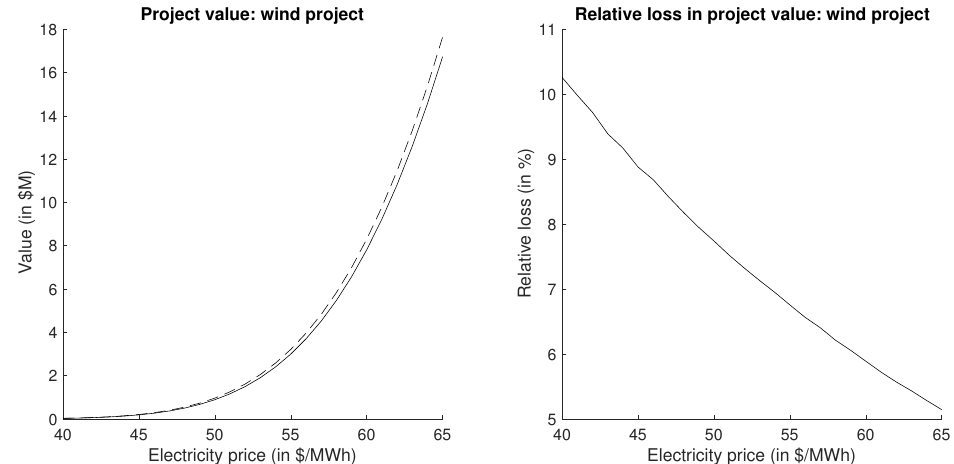
Figure 2. This figure shows the impact on the value of wind project at t = 0. Left panel plots the project value, solid line corresponds to the pandemic case, dashed line to the no-pandemic case. Right panel plots relative loss due to the pandemic in %. Parameter values are given in Table 1; the investment horizon is T = 1 year.